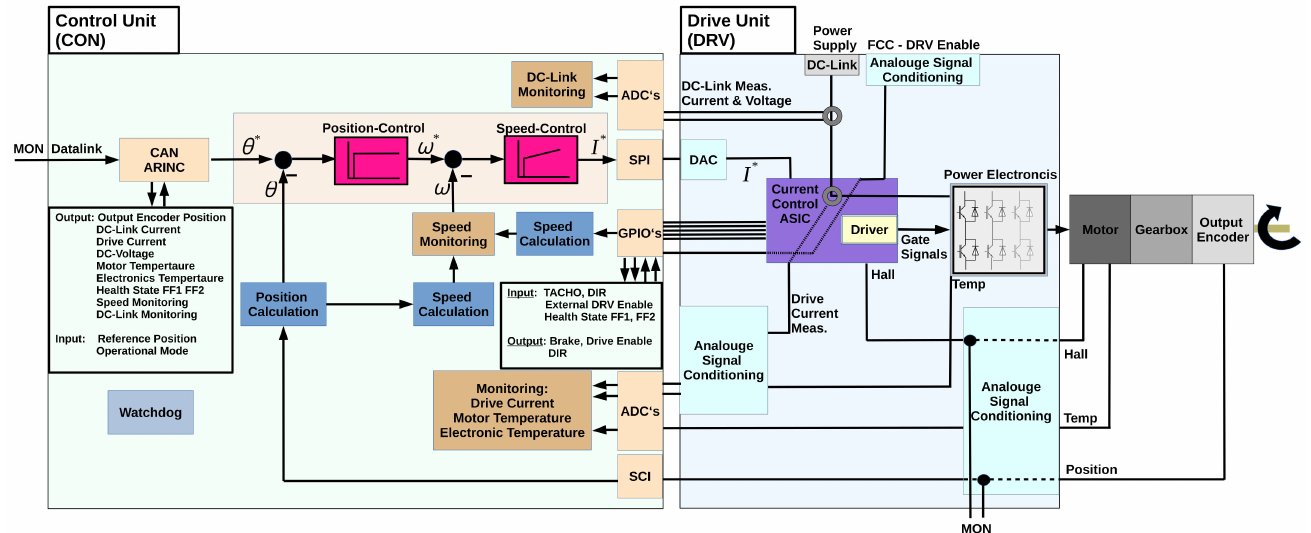
Figure 14. Overview of the electronic and software architecture (one of two identical